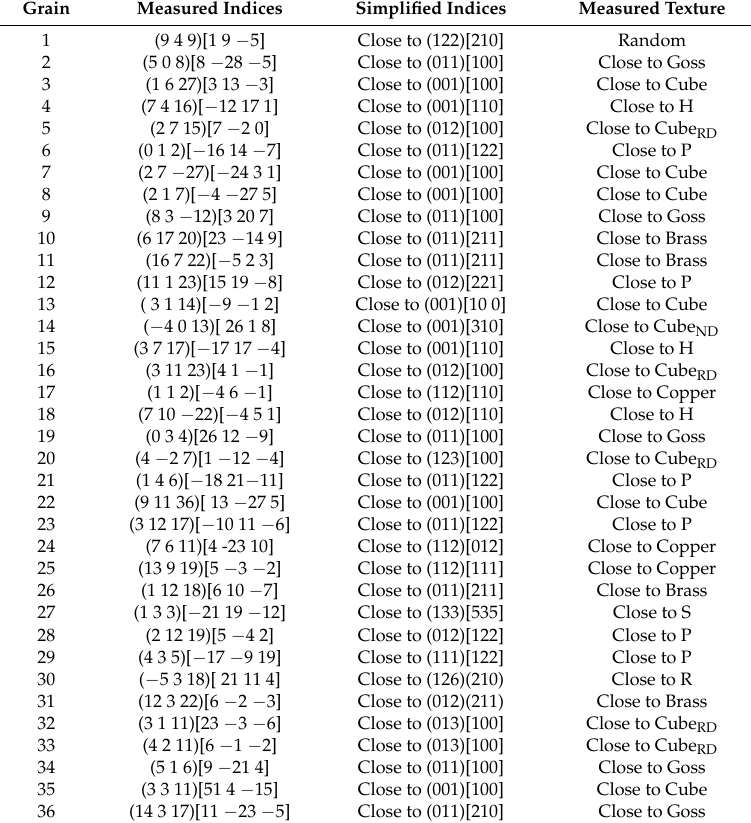
Table 4. The orientations of grains near fatigue crack in sample